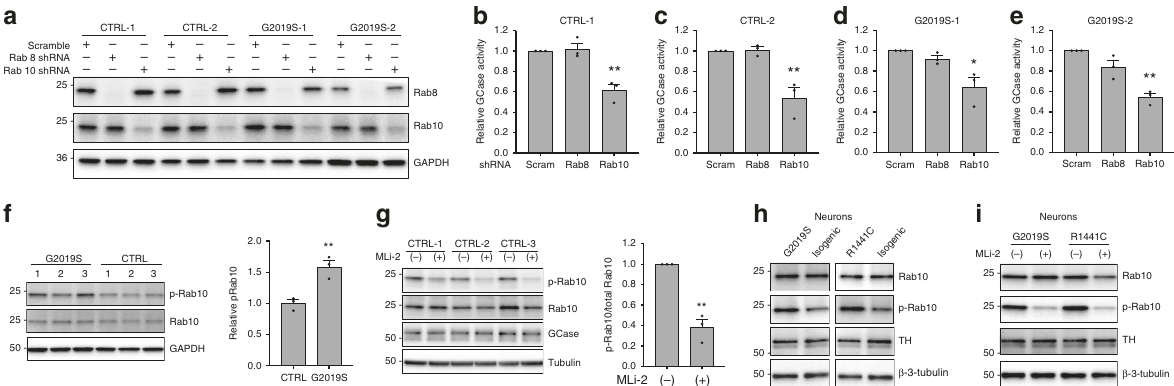
Fig. 5 Rab10 is a mediator of GCase activity by LRRK2 in fi broblasts and DA neurons. Western blot analysis of fi broblasts, from healthy controls or from patients with the LRRK2 G2019S mutation treated with lentivirus encoding Rab8 and Rab10 shRNA, probed for Rab8, Rab10, and GAPDH (loading control) a . Examination of relative lysosomal GCase activity in fi broblasts upon Rab8 and Rab10 knock-down b – e . Western blot analysis of fi broblasts from 3 patients with LRRK2 G2019S and from 3 healthy controls were probed for phospho-Rab10 (p-Rab10), Rab10, and GAPDH (loading control). The data is presented as the average p-Rab10 signal for the 3 G2019S samples relative to the 3 controls f . Western blot analysis of fi broblasts from 3 controls treated with MLi-2 were probed for phospho-Rab10 (p-Rab10), Rab10, GCase, and tubulin (loading control). Data is presented as the ratio of p-Rab10 to total Rab10 for the treated relative to untreated cells g . Representative western blots of lysates from LRRK2 G2019S and R1441C DA neurons relative to the corresponding isogenic controls h or relative to MLi-2 treated neurons i were probed for p-Rab10, Rab10 and β -3-tubulin (loading control). The data are presented as the mean ± SEM, n = 3; * p < 0.05, ** p < 0.01, using one-way ANOVA followed by Tukey ’ s multiple comparison post hoc test b – e , or paired